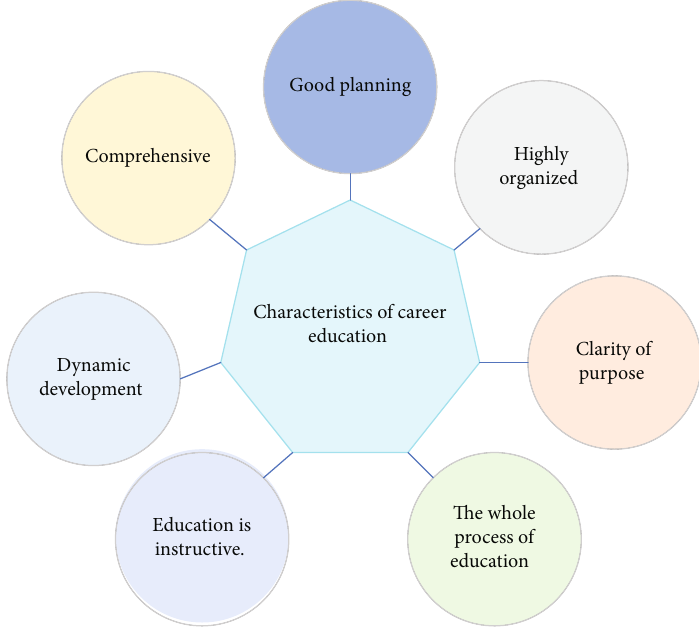
Figure 2: Characteristics of career Table 1: Distribution of objects.